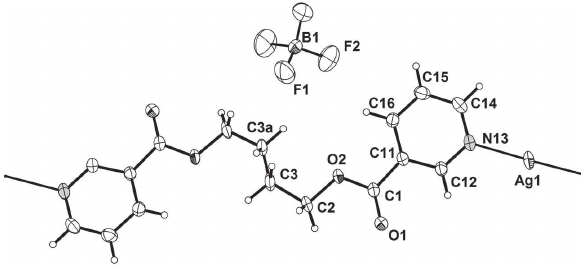
Table 1: Data collection and